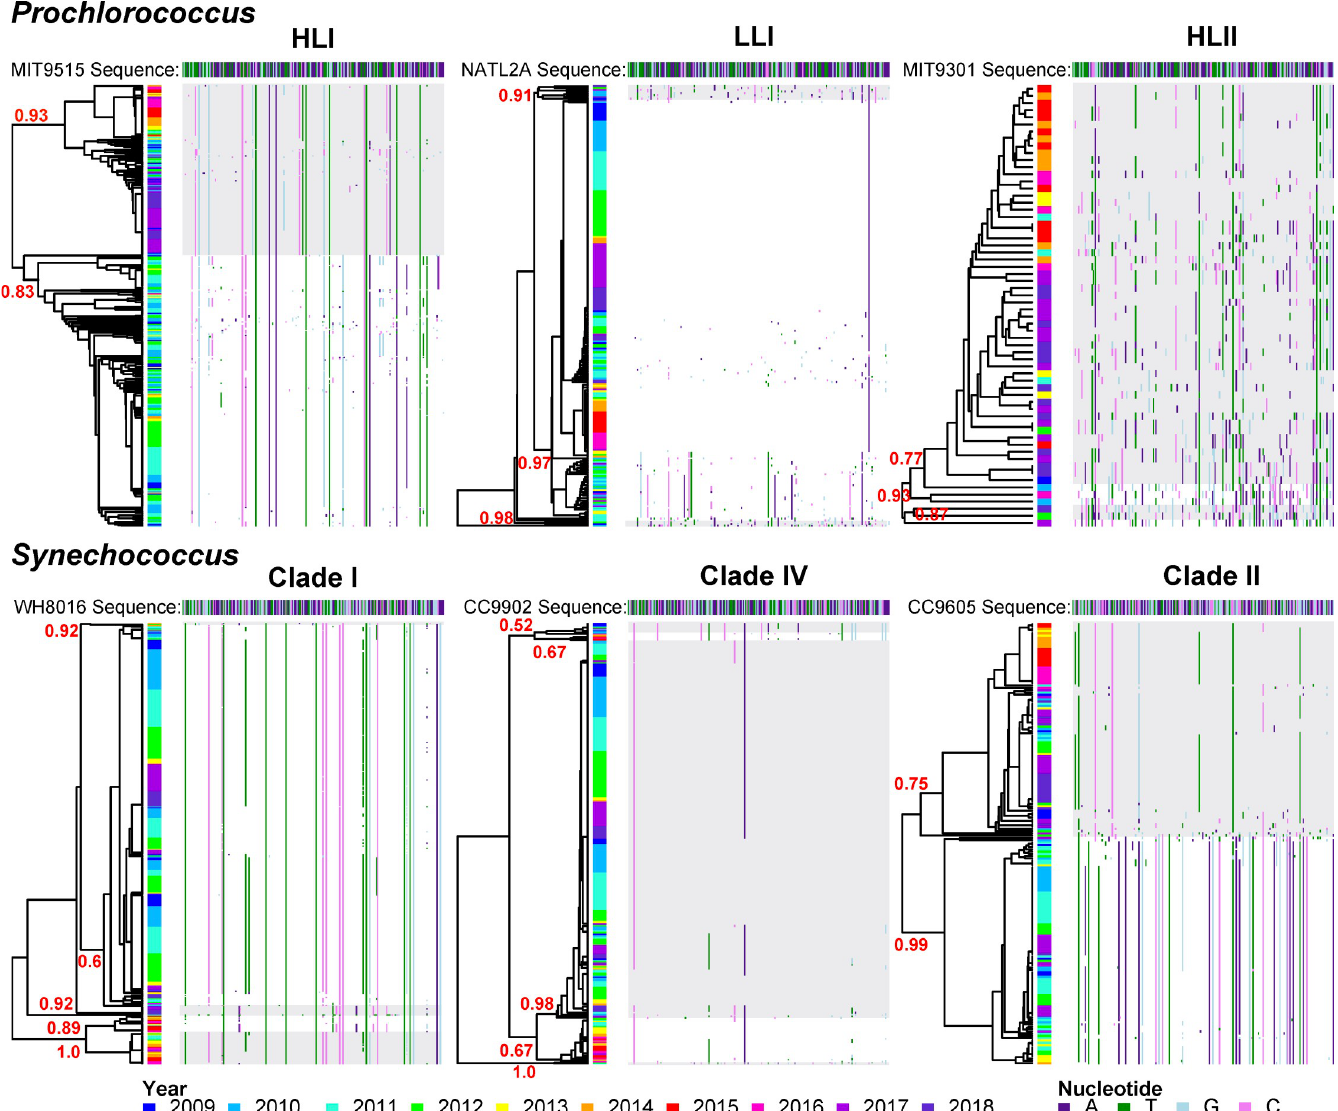
Fig 3. Microdiversity clusters within the most abundant Prochlorococcus and Synechococcus ecotypes were temporally and statistically stable. Dendrograms represent the average-linkage hierarchical clustering of single nucleotide polymorphisms (SNP) differences between a rpo C1 reference sequence and the majority consensus sequence at each sampling time point. Each row of the dendrogram represents the consensus rpo C1 sequence at a time point, where only SNPs (in comparison to the reference sequence) are depicted. Only time points where the ecotype was present are shown. The reference rpo C1 sequence is depicted at the top of each dendrogram. Reference genomes used to compare rpo C1 sequences included: HLI–MIT9515; LLI–NATL2A; HLII–MIT9301; Clade I–WH8016; Clade IV– CC9902; and, Clade II–CC9605. Within-cluster sum of squares was used to determine the optimum number of SNP-based clusters (i.e., haplotypes). Cluster labels (red) indicate bootstrapped Jaccard similarity values for the most stable clusters (values < 0.5 are unstable, 0.6–0.75 weak stability, 0.75–0.85 stable, and > 0.85 highly stable). Stable clusters are alternately shaded in grey for emphasis.